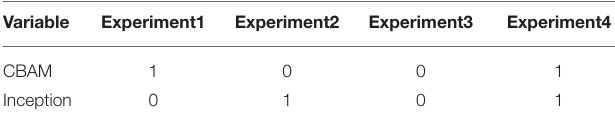
TABLE 4 | Control of variables in the ablation experiment, where 0 means that the corresponding module is not used and 1 means that the corresponding module is